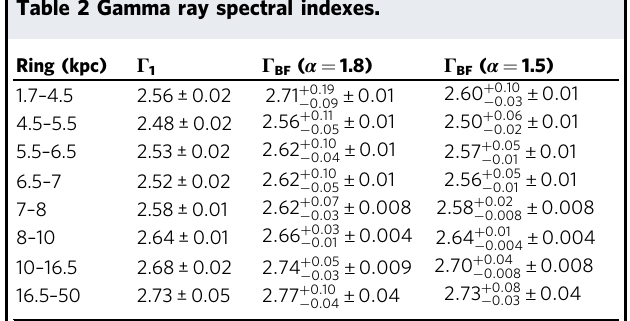
Gamma ray spectral indexes of the diffuse emission due to CRs interaction obtained by fi tting the Fermi-LAT data with ( Γ BF ) and without ( Γ 1 ) TeV Pulsar Wind Nebulae unresolved contribution. The spectral index ( Γ BF ) is given for two different assumptions on the luminosity index α . The fi rst error associated to Γ BF represents the systematic uncertainty (due to variationsoftheratio R Φ betweentheintegrated fl uxintheGeVenergyrangeandtheoneinthe TeV energy range, the spectral energy break E 0 and the TeV spectral index β TeV ) while the second is the statistical one. The indexes Γ 1 coincide with those obtained by previous analysis 2 .